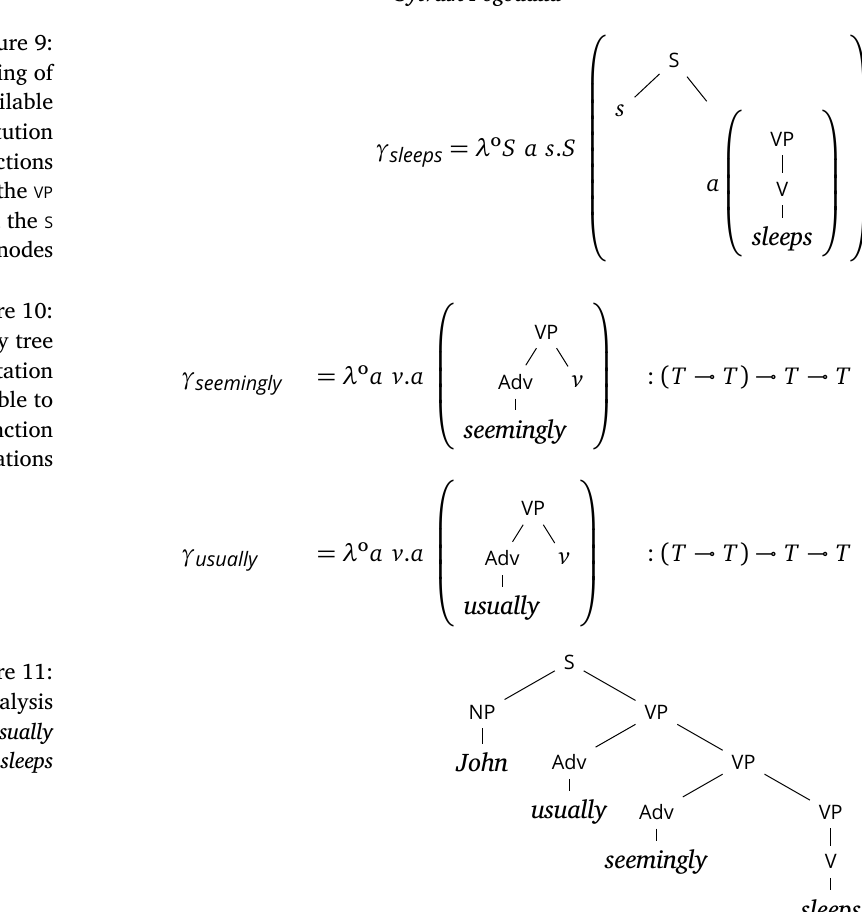
Encoding of (cid:11) sleeps available